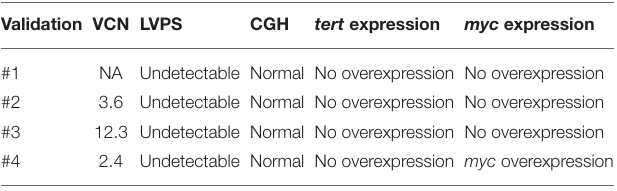
TABLE 4 | Results from genetic tests.